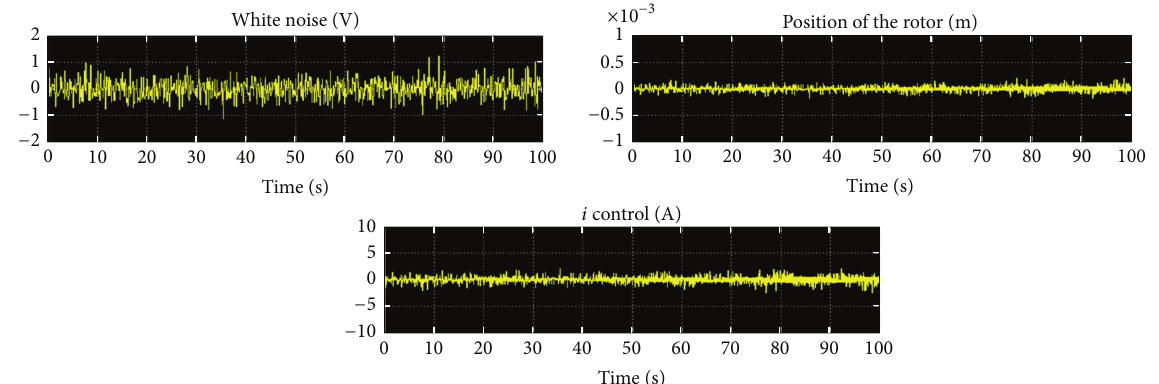
Figure 6: System response with P controller with proportional gain of 12000 and white noise of 0.01 volts.